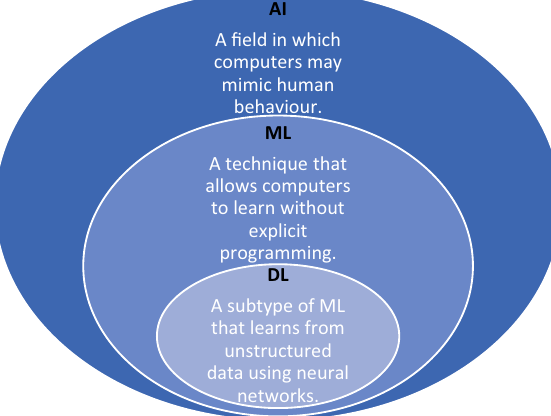
Fig. 2 Artificial Intelligence vs. Machine Learning vs. Deep